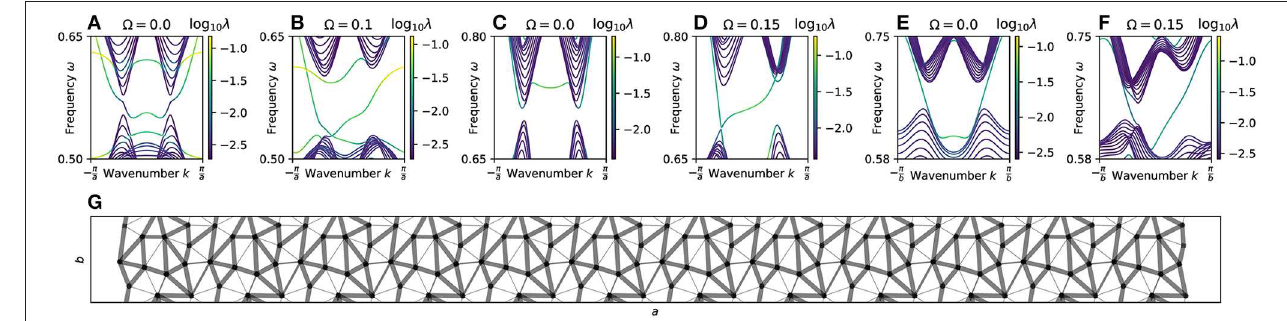
FIGURE 2 | Topologically protected edge bands. Considering the same networks as in Figure 1 , we constructed ribbon-like 1D crystal realizations that are infinitely periodic in one lattice direction, and of finite extent (12 unit cells wide) with open boundary conditions in the other direction; see example in (G) , which corresponds to 12 horizontally concatenated units of the network in Figure 1E periodically continued along the vertical direction. (A–F) The resulting one-dimensional band structures consist of bulk bands that are delocalized (dark blue) and localized edge bands (green and yellow). All bands are colored according to the how localized the corresponding modes are, with the localization of a mode u ( k ) being measured by the participation ratio λ in the unit cell of the ribbon. (A,B) Correspond to the optimized network topology in Figure 1A ; (C,D) correspond to the network topology in Figure 1C ; (E,F) correspond to the network topology in Figure 1E . Generically, networks designed via LRO can and will have localized edge modes even in the topologically trivial (cid:127) < (cid:127) c , see (A,C,E) . However, when the topological phase transition is crossed at some nonzero rotation rate regime | | bands appear as evident from (B,D,F) . We note that the frequency of rotation is always smaller than the gap frequency (cid:127) 2